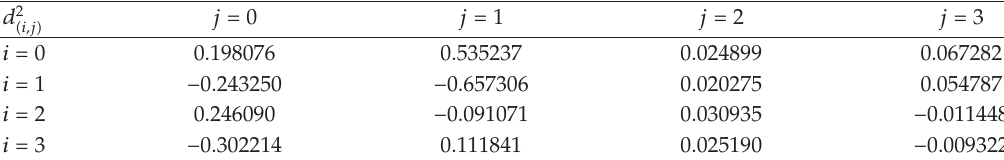
Table 3: The coe ffi cients of a high-pass wavelet filter (cid:3) d 2 (cid:3) i,j (cid:4) (cid:4) associated with the low-pass wavelet filter in Table 1.